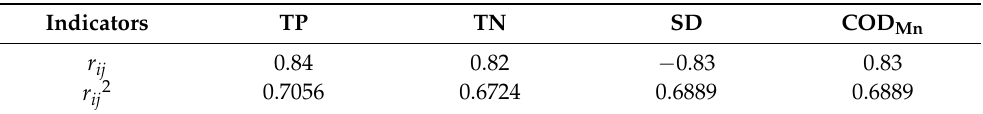
Table 4. The values r ij and r ij 2 of the correlation between some indicators of lakes (reservoirs) and the concentration of Chla in China [14].